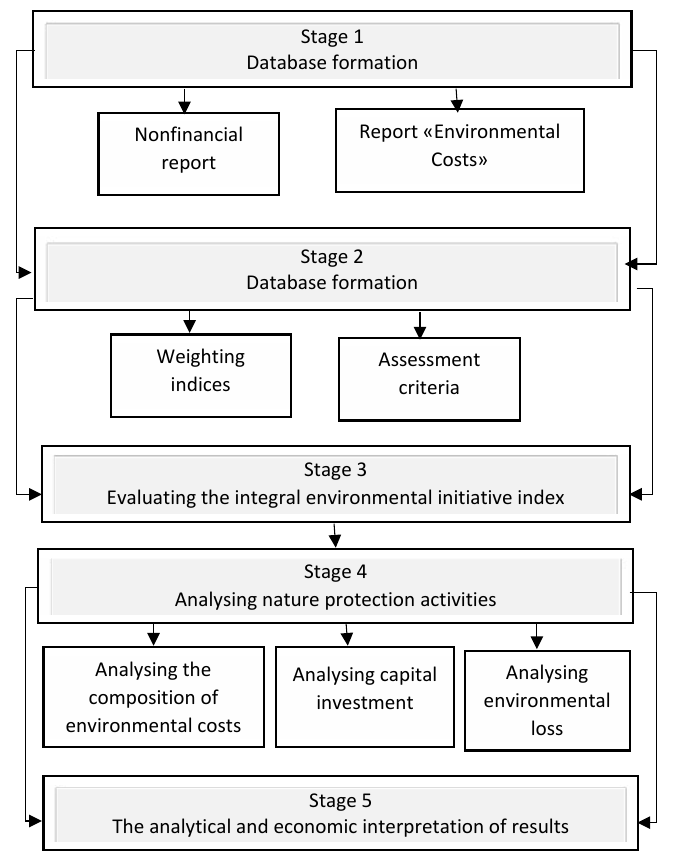
Fig. 1: Stages of assessing the environmental initiative of industrial enterprises